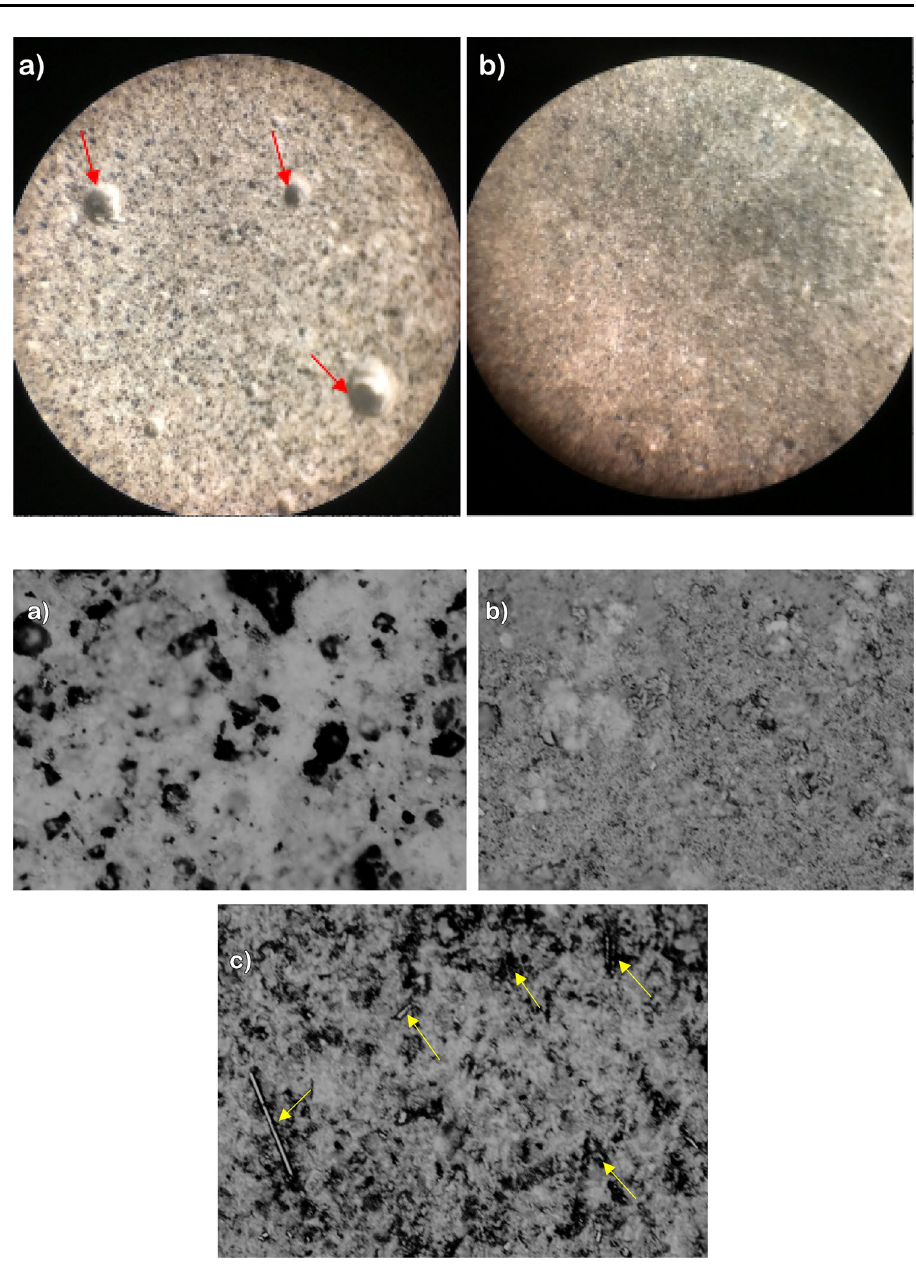
Fig. 9 a, b. 70 × surface magnification of low-pressure